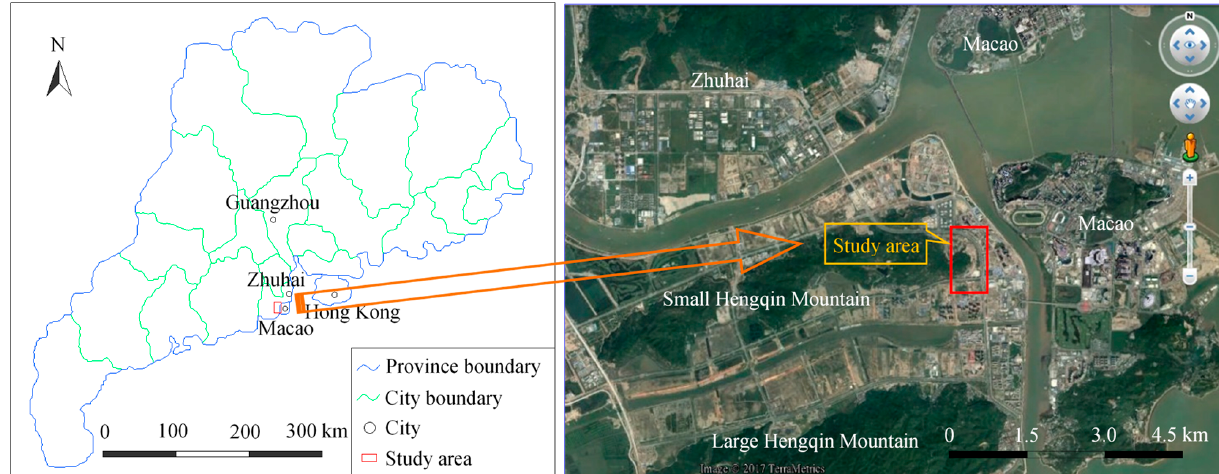
Figure 1. Location and topography of the study area.